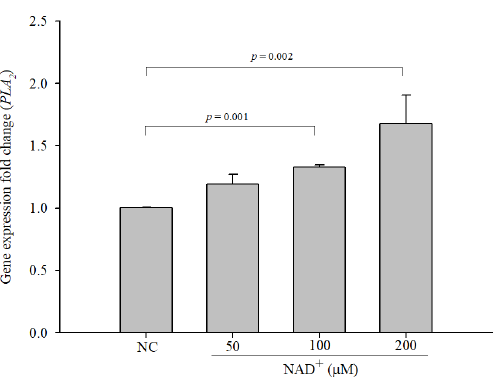
Figure 4. The expression levels of phospholipase A2 (PLA 2 ) were increased in NAD + -treated cells. PLA 2 expression levels were measured by qPCR. The data are expressed as the mean ± SD of three independent experiments performed in triplicate.